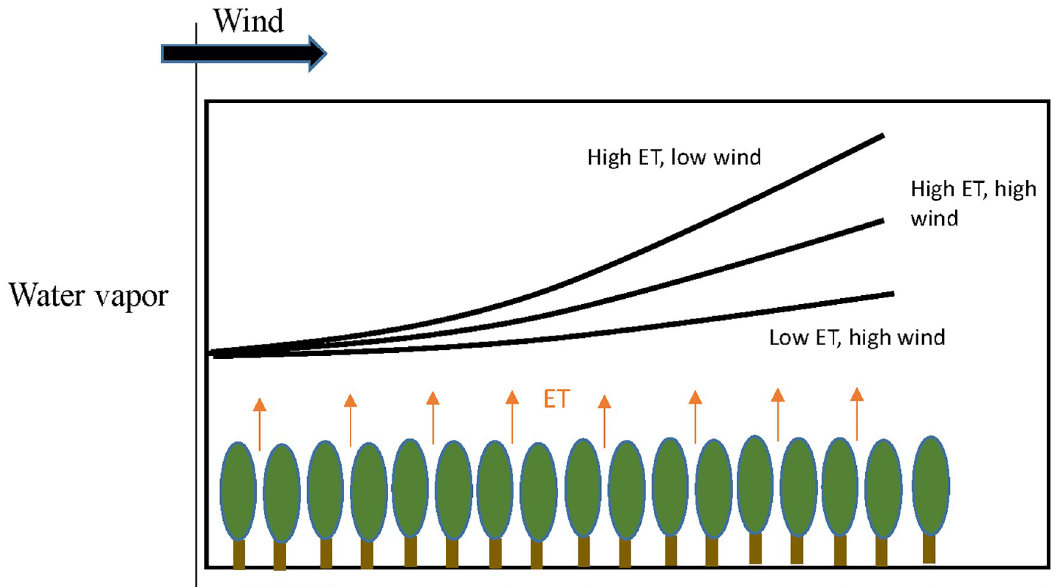
Fig 1. Conceptual schematic of columnar water vapor as it is affected by ET rates and wind, modified from Ogunjemiyo et al. [4].